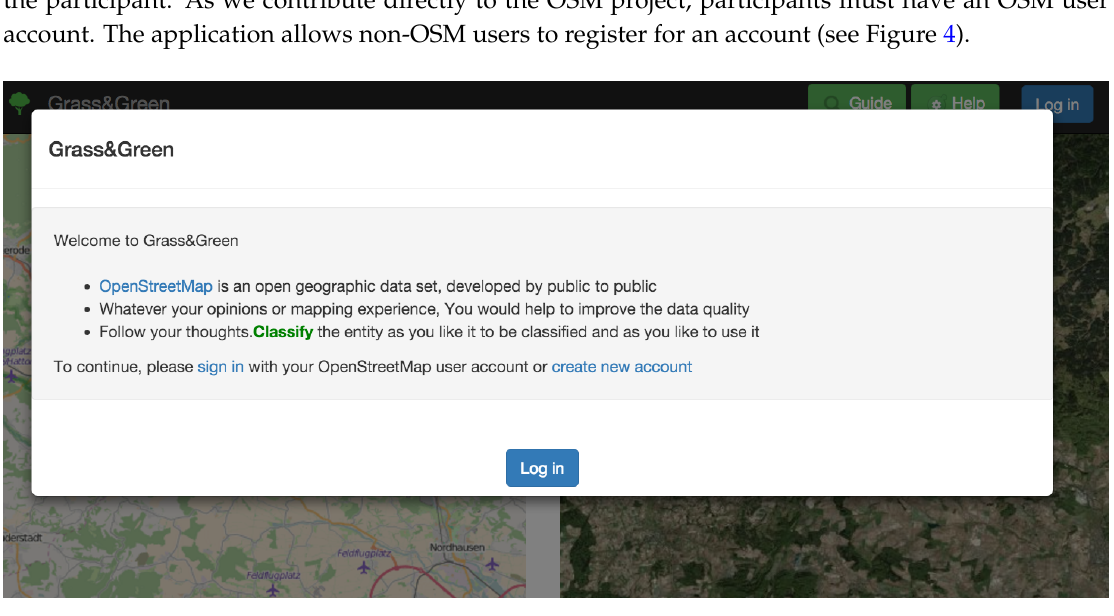
Figure 4. Application instructions and the OSM user login